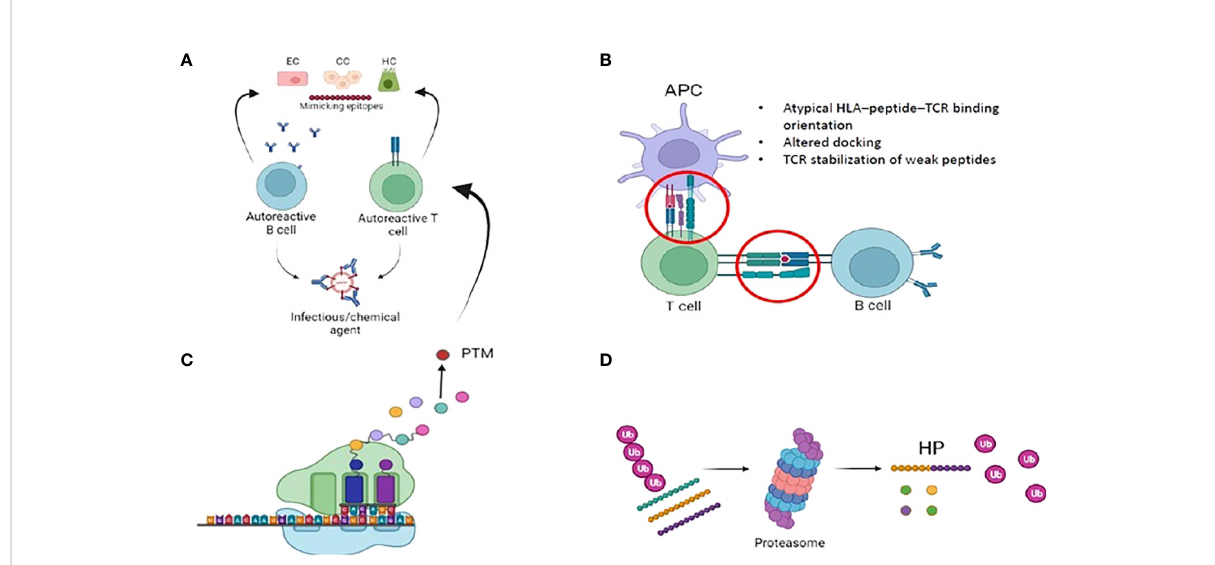
FIGURE 2 Imperfect HLA interactions and autoimmunity: (A) Molecular mimicry: Foreign antigens (i.e. either from infecious or chemical agents) with similarities to self-antigens are primed by T and B cells, that autoreactive and trigger autoimmunity. (B) Immunological synapse and autoimmunity: several mechanisms of the complex interplay between APC, B- and T- cells might lead to the activation of autoimmune B and T cells. Among them, mechanical binding alterations (atypical binding orientation, altered docking) and TCR stabilization of weak peptide. Weak HLA binding of self-peptides might contribute to autoimmunity by allowing the escape of autoreactive T-cellsfrom the thymus. (C) Post translational modi fi cations (PTM): they are spontaneous or enzymatically induced modi fi cations of one or more amino acids occuring after protein biosynthesis. After PTM, these proteins become modi fi ed self-antigens, and they do not “ tolerize ” developing thymocytes. Consequently, modi fi ed self-antigens can be taken and processed by APC, that will present them to autoreacitve T and B cells. (D) : Generation of hybrid peptides: proteasomal-mediated degradation and splicing of intracellular self-peptides can promote the generation of non-self-hybrid peptides. This mechanism occurs with high protein concentrations in a con fi ned environment, that favours protease-mediated peptide